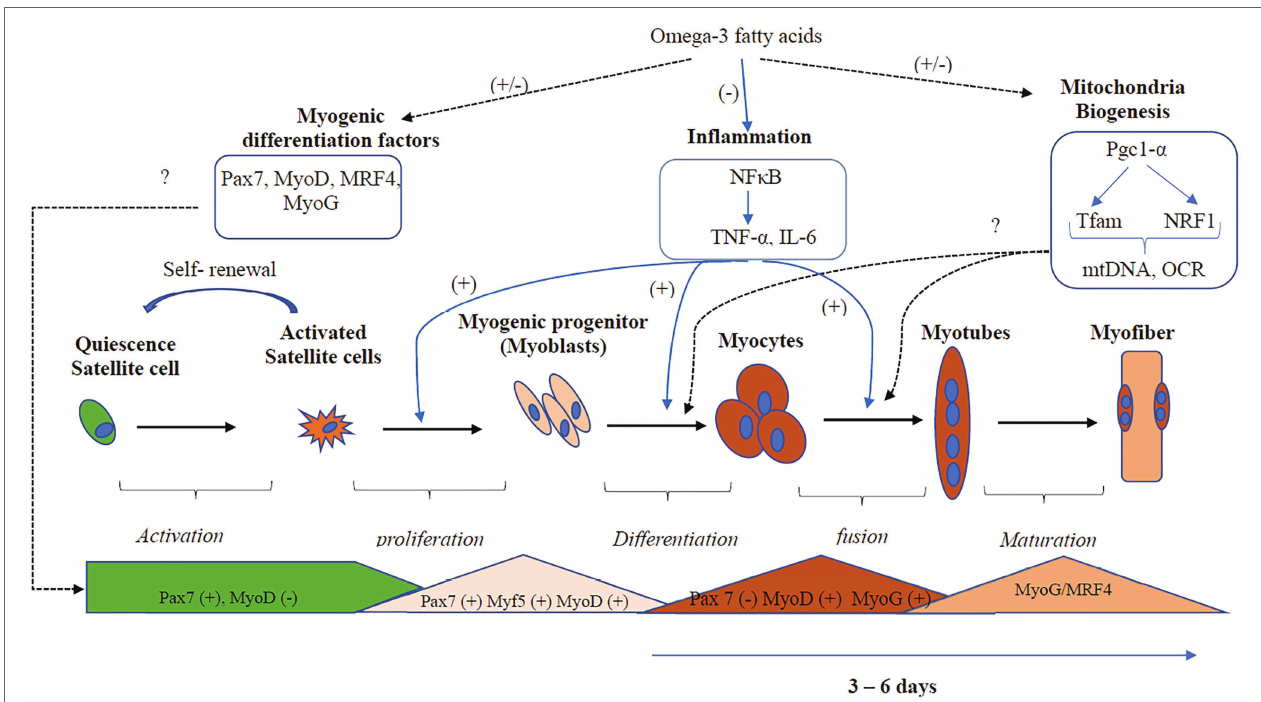
FIGURE 3 | Regulation of inflammation and mitochondria biogenesis by Omega-3 polyunsaturated fatty acids (PUFA) during myogenic differentiation. Omega-3 PUFA inhibits the activation of the inflammatory pathways, thus promoting myogenic differentiation. However, the effects of Omega-3 PUFA on the regulation of the transcription factors that regulate myogenesis and mitochondria biogenesis are inconsistent. Three out of the six studies reported decreased expression, while three studies reported increased expression of myogenic differentiation factors. Two studies reported a decrease in mitochondria biogenesis, while three studies reported decreased expression. Overall, more studies are needed to confirm the actual effect of omega-3 PUFA on mitochondria biogenesis and the transcription factors that regulate myogenesis. Dotted black lines represent pathways that show an inconsistent result, the blue lines represent pathways that show a consistent result. mtDNA, mitochondria DNA; Myf5 , Myogenic factor 5; MyoD, myoblast determination protein 1; MyoG, myogenin; MRF, myogenic regulatory transcription factor; NF- κ B, nuclear factor kappa B ; OCR, oxygen consumption rate; Pgc-1 α , peroxisome proliferator-activated receptor gamma co-activator 1-alpha; Pax, Paired box protein; TNF- α , tumor necrosis factor; Tfam, mitochondrial transcription factor